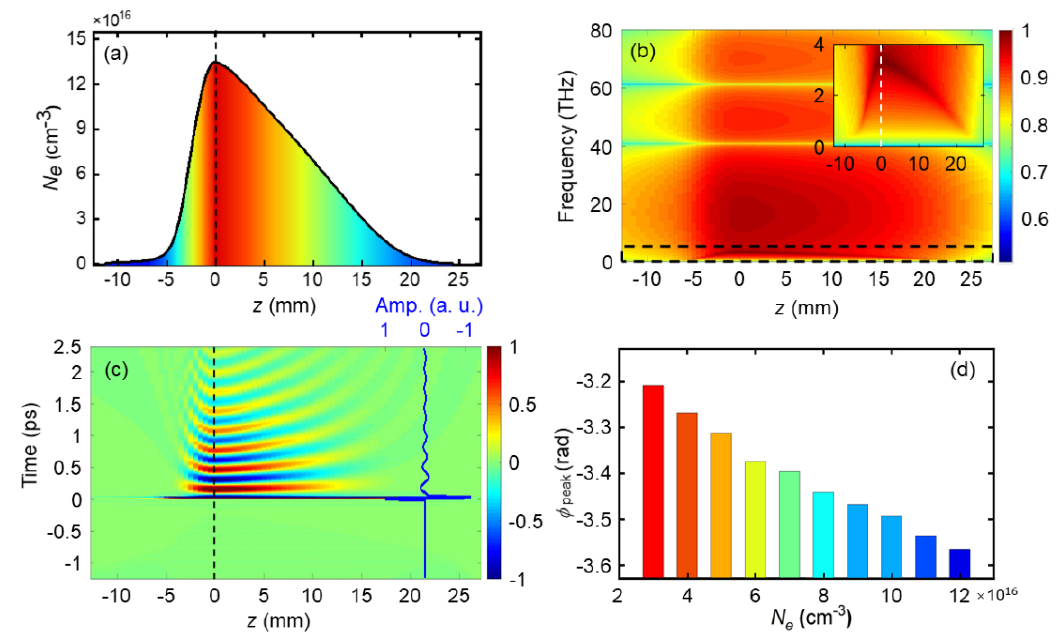
Figure 3: THz signals in both time and frequency domains along the plasma fila- ment with an inhomogeneous N distribution. (a) The simulated longitudinal Ne e distribution along the propagation axis z of the plasma filament. (b) 2-D THz ampli- tude distributions as functions of z and THz frequency. Inset: the enlarged view of low THz band ( < 4 THz) within the black dashed box. (c) 2-D THz amplitude distri- butions as functions of z and time delay, achieved by inverse Fourier Transformations (iFT) on (b). The blue waveform on the right-hand side, given by z -integration, de- notes the THz transient emitted from the entire plasma filament. (d) The phase of spectral peak φ ) decreases with the increasing N , obtained from Fig. 2(b peak e 2